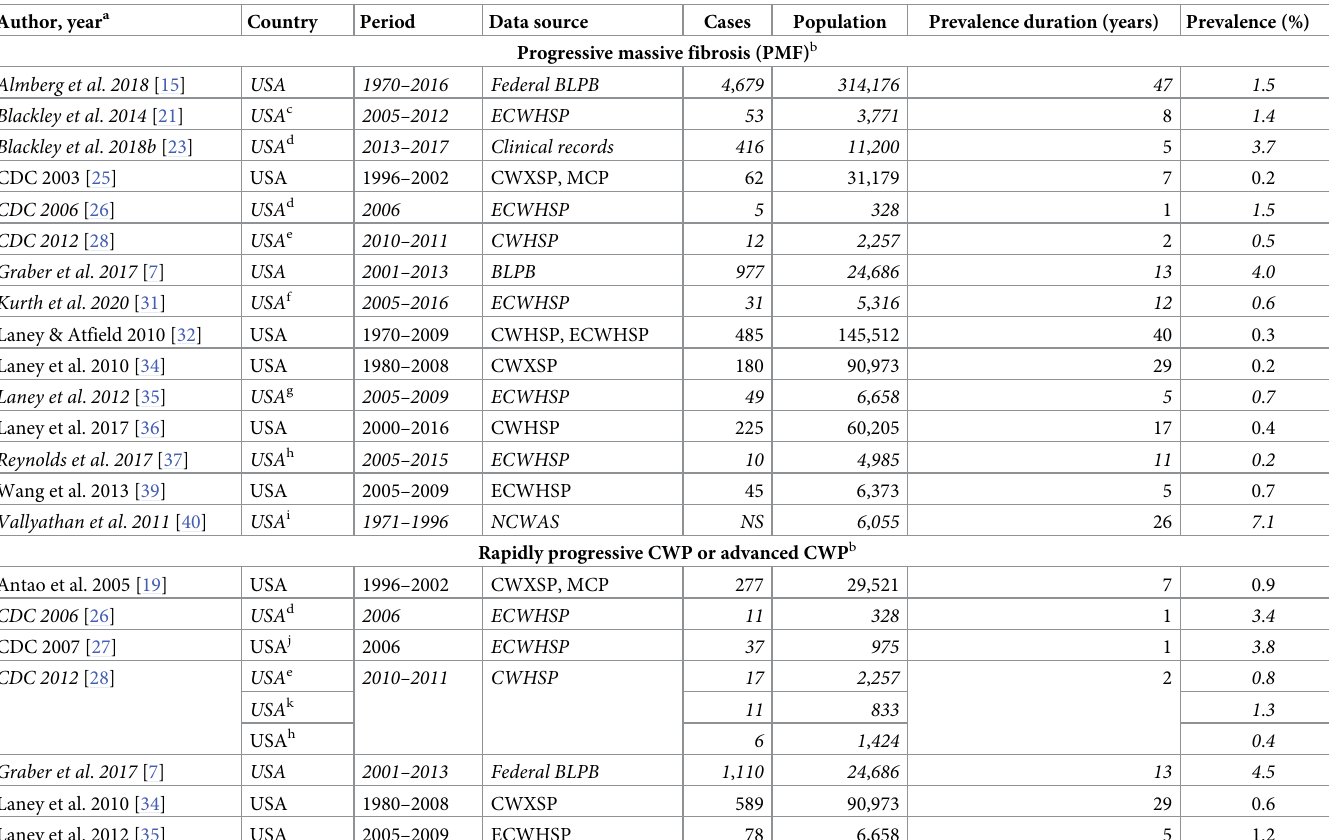
Table 4. Summary of included studies on prevalence of coal workers pneumoconiosis (CWP) by disease